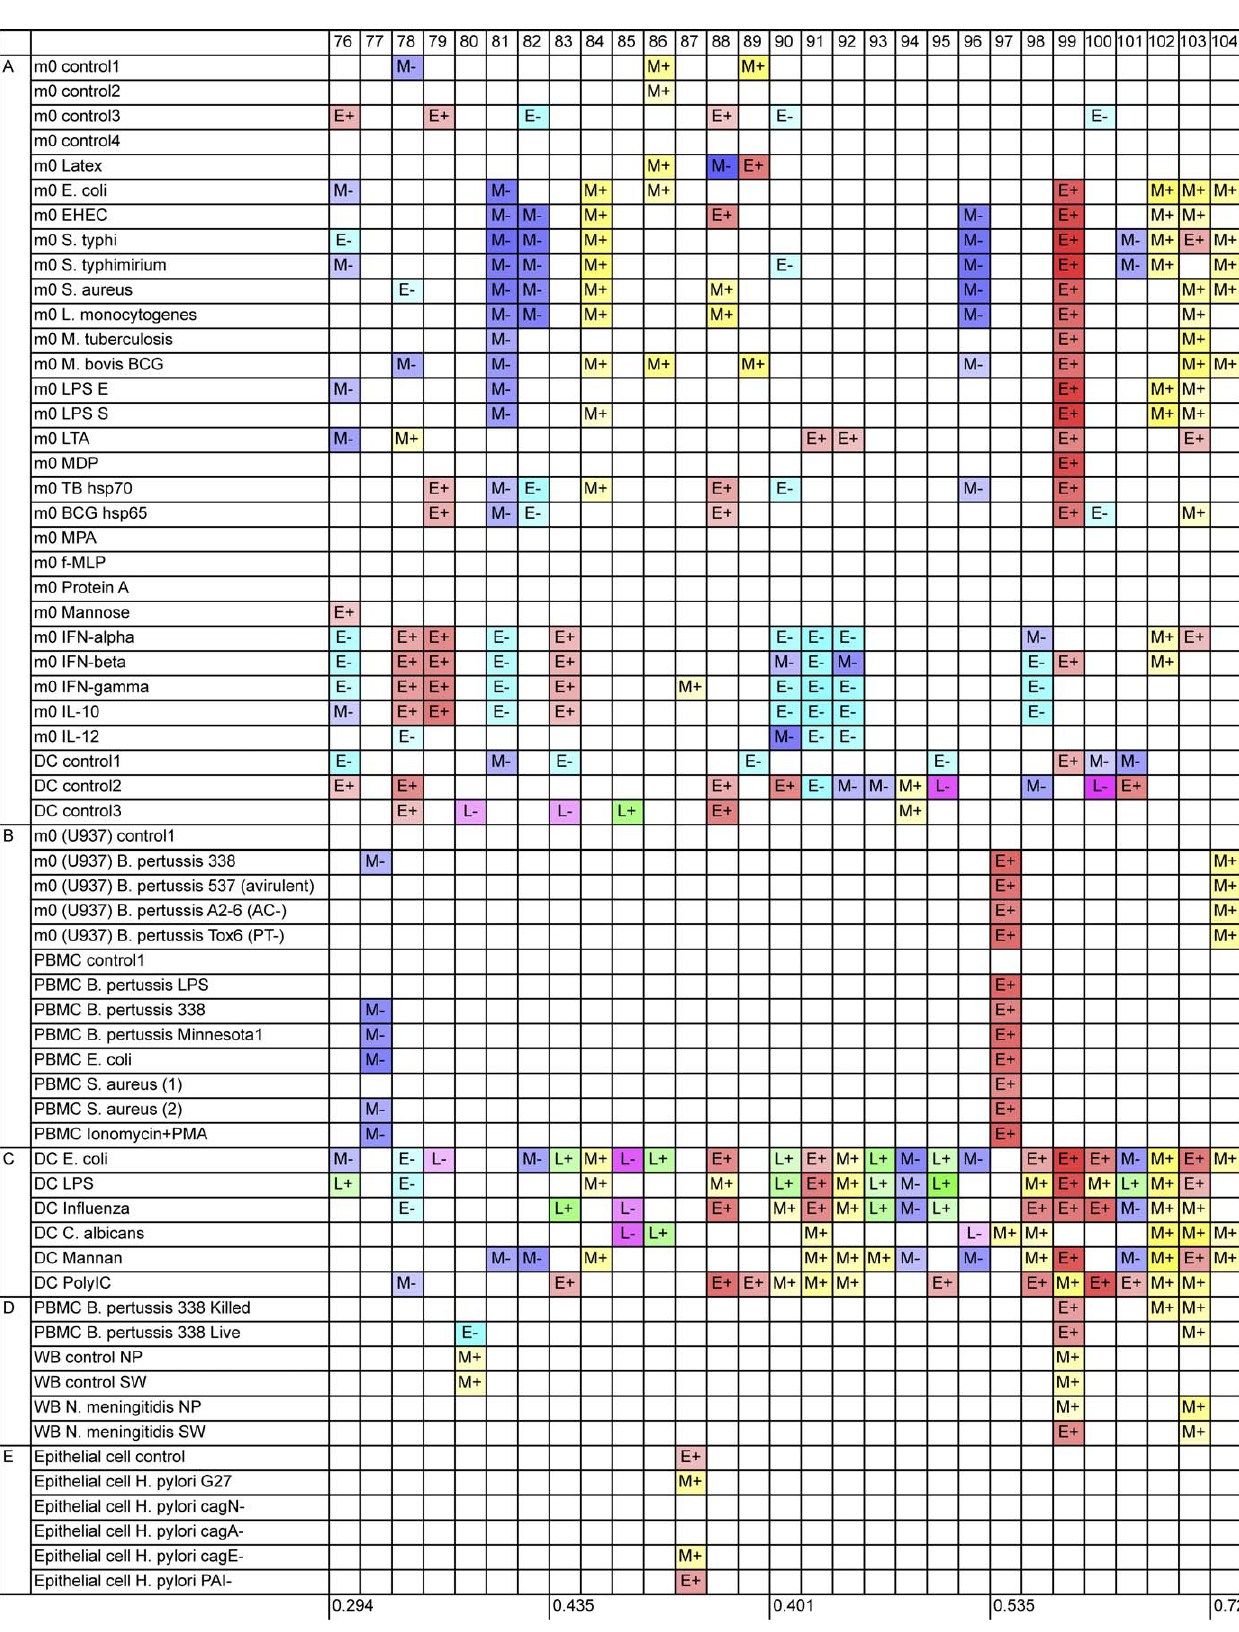
Figure 6. GeneProgram Discovered Five Tissue Groups (A–E) and 104 Expression Programs (Numbered Columns, Only 76–104 Shown Here; 1–75 Shown in Figures S3–S5) in a Compendium of 62 Short Time-Series Gene Expression Datasets Measuring the Responses of Human Cells to Infectious Agents and Immune-Modulating Molecules PLoS Computational Biology |